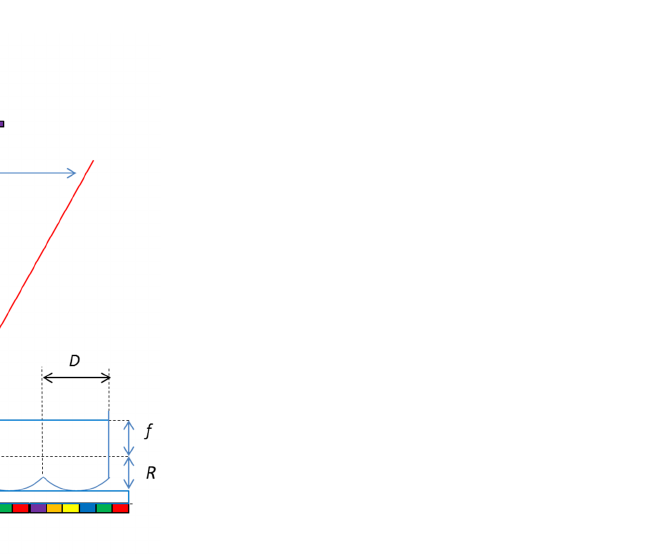
Table 2. Characteristics of mobile phones.